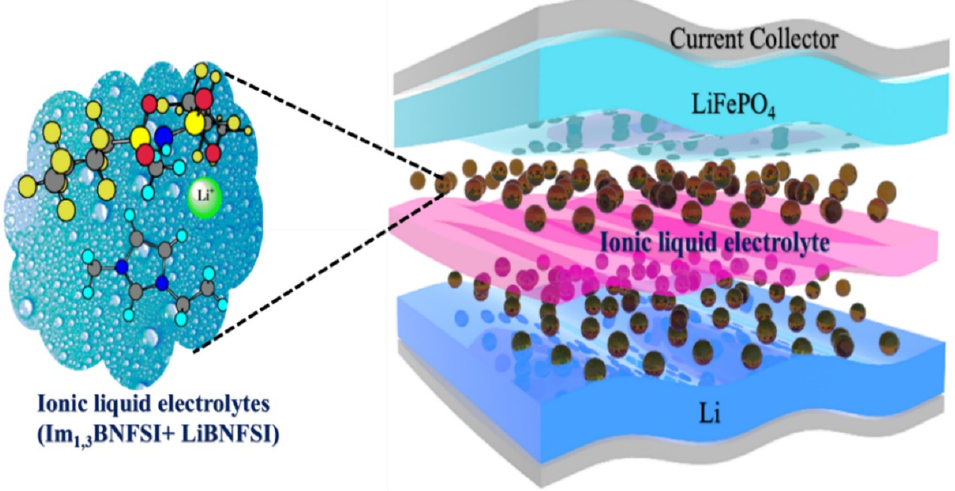
Figure 17. Non-aqueous liquid electrolytes based on 1-ethyl 3-methylimidazolium bis(nonafluorobutane-1-sulfonyl imidate) ionic liquid. Reprinted/adapted with permission from Ref. [59]. 2020, Elsevier.